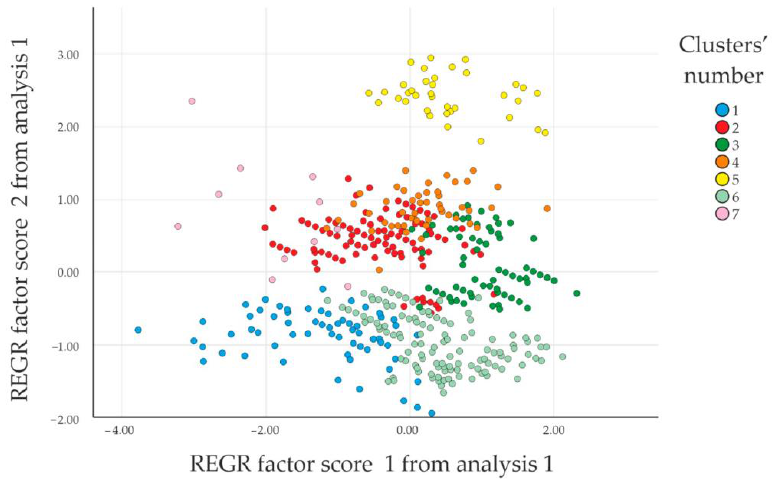
Figure 9. Scatter plot (REGR: regression).